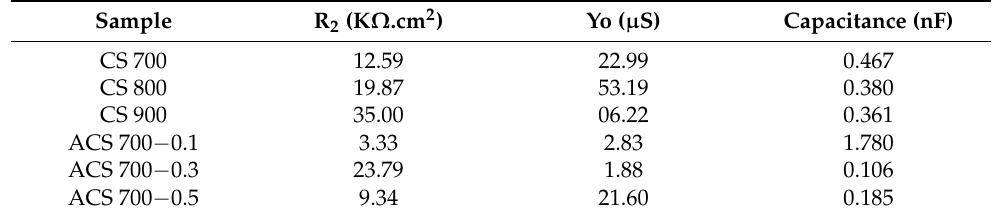
Table 4. EIS parameters from Nyquist plots calculated theoretically from equivalent circuit